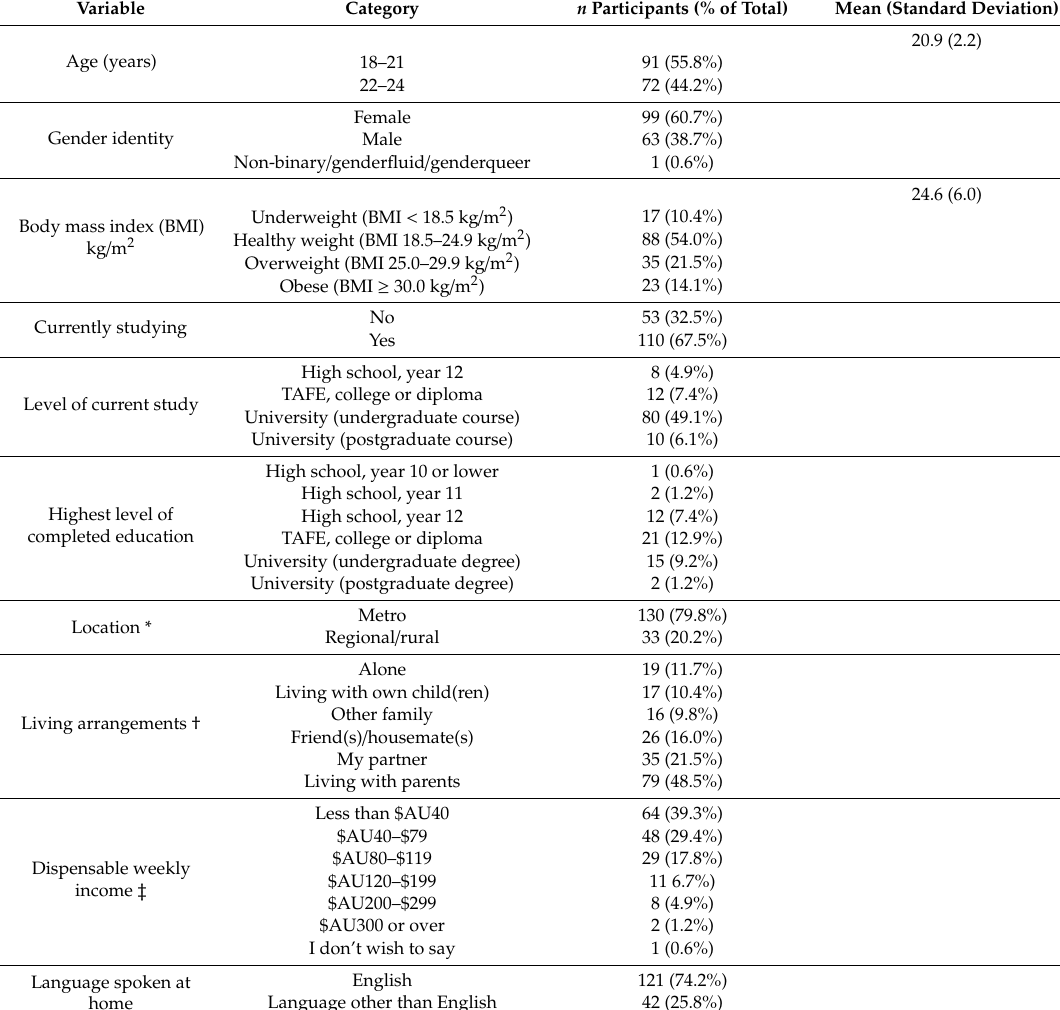
Table 2. Participant characteristics of those completing at least one forum / challenge analysed ( n = 163